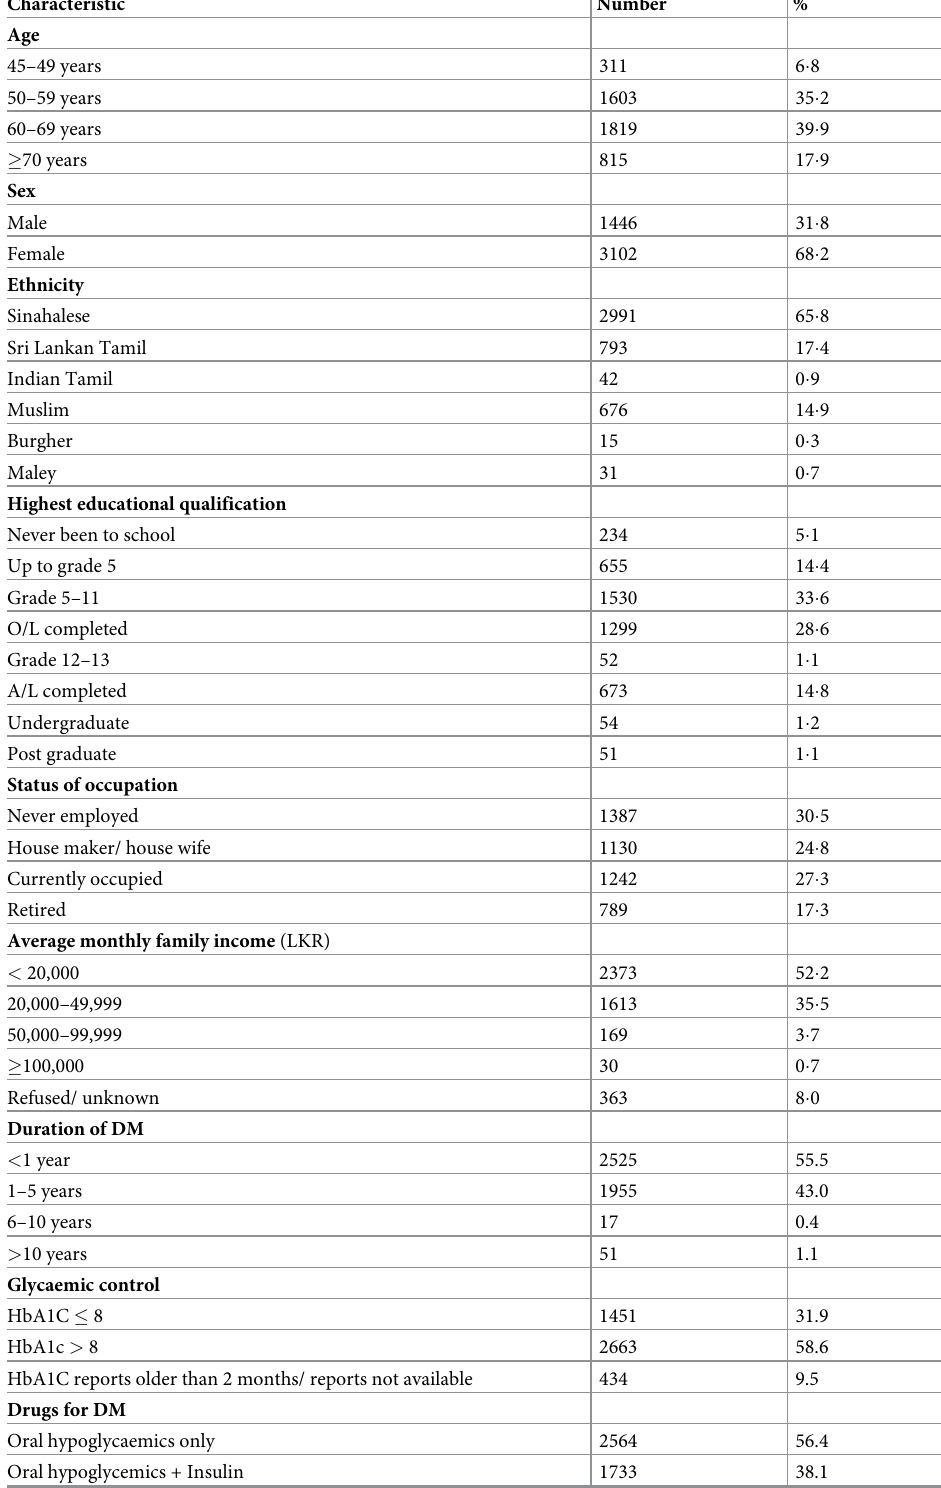
Table 1. Distribution of basic socio-demographic and illness-related characteristics of the study